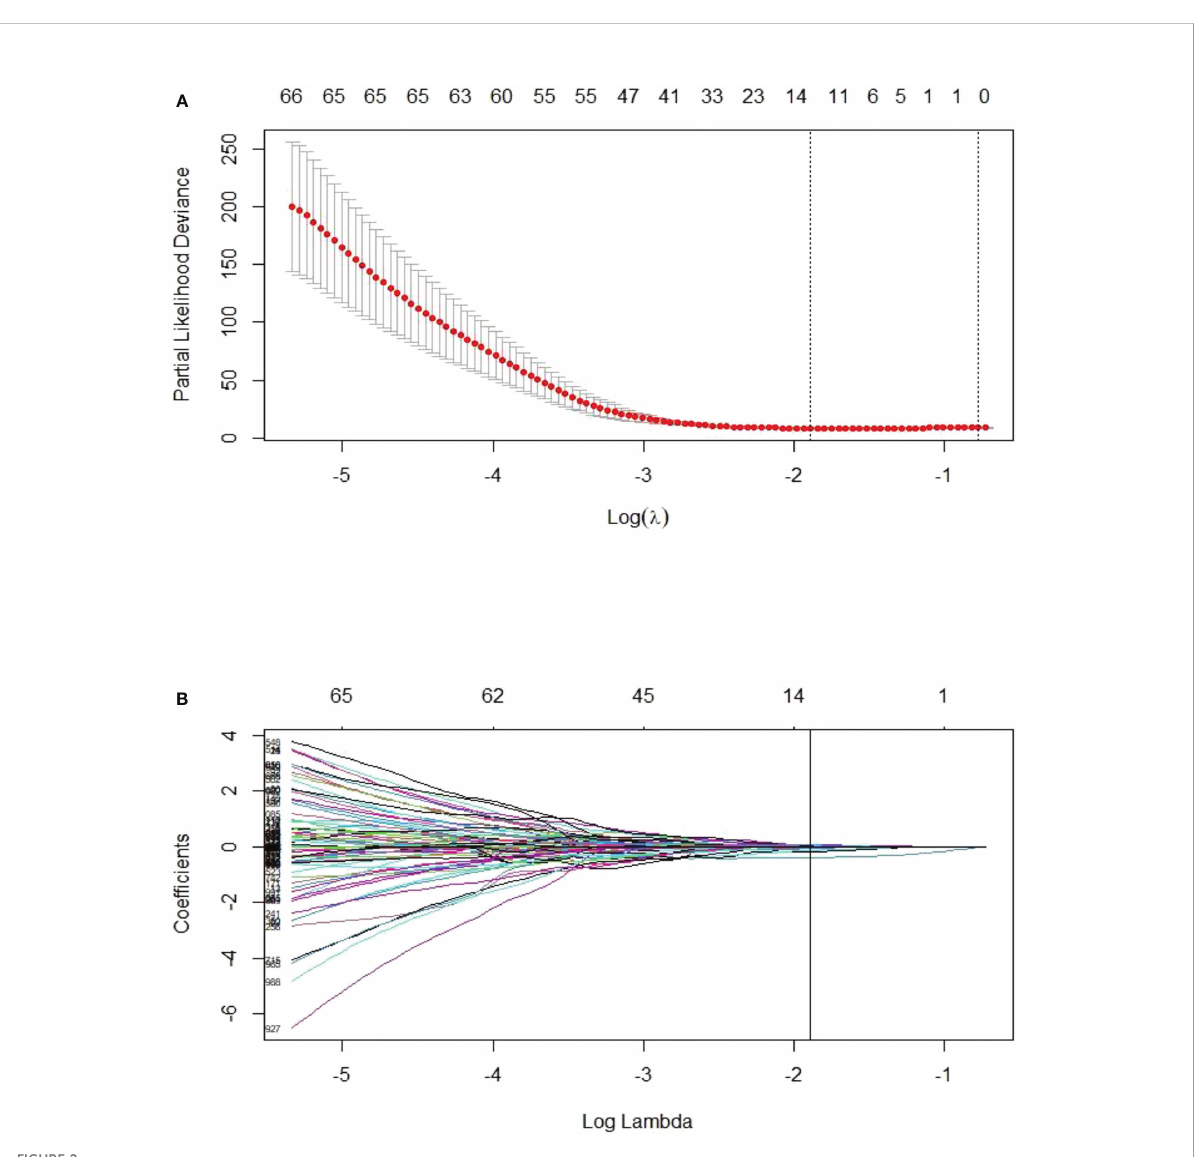
FIGURE 2 LASSO Cox regression model for delta radiomics feature screening. (A) The dashed line on the left side of the horizontal coordinate represents the selection of the best log( l ) = -1.8905 in the model by tenfold cross-validation. (B) Coef fi cient convergence plots of the screened features, with black vertical lines corresponding to the best log( l ) values, screened for 12 nonzero coef fi cients of delta